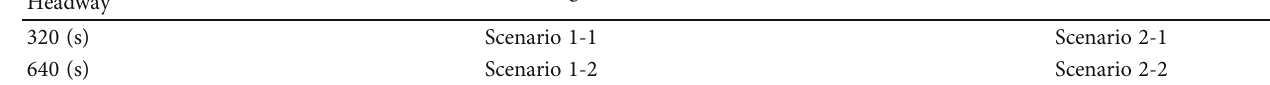
Table 3: Simulation